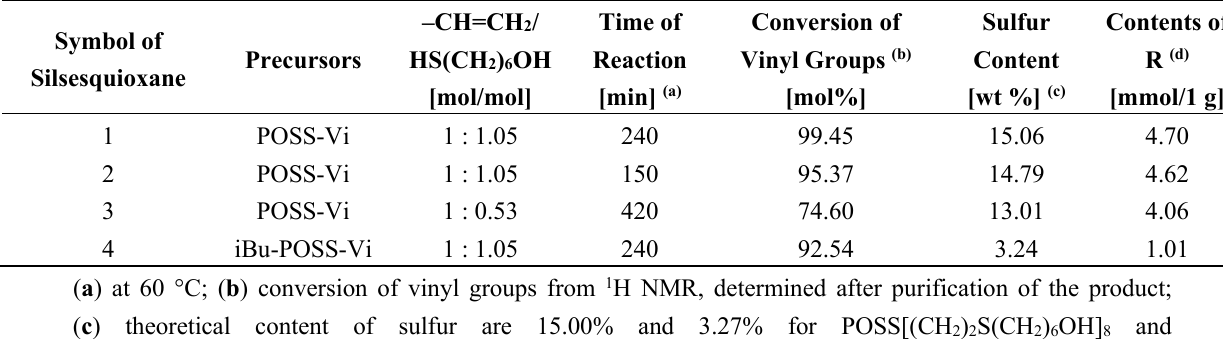
iBu-POSS-Vi 1 : 1.05 240